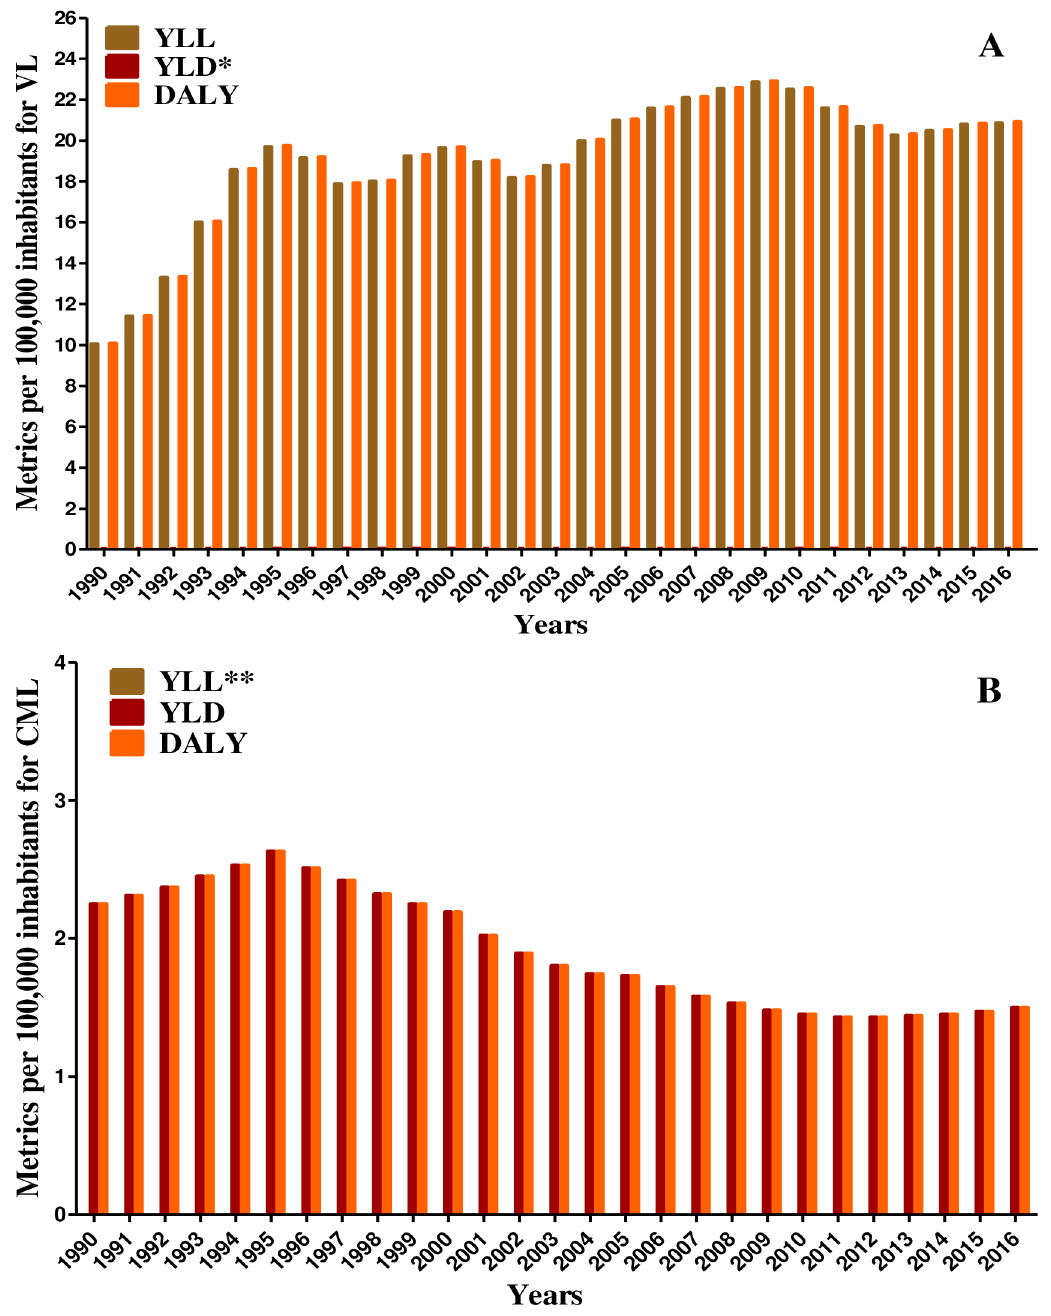
Fig 1. Age-standardized rates of years of life lost (YLL), years lived with disability (YLD), and disability-adjusted life years (DALY) per 100,000 inhabitants for Visceral Leishmaniasis (VL) (A) and Cutaneous and Mucocutaneous Leishmaniasis (CML) (B) per 100,000 inhabitants, Brazil, 1990 to 2016, GBD Study 2016. (cid:3) Visceral Leishmaniasis values of YLD are less than one. (cid:3)(cid:3) Cutaneous and Mucocutaneous Leishmaniasis mortality was assumed to be zero and for this reason YLL values are